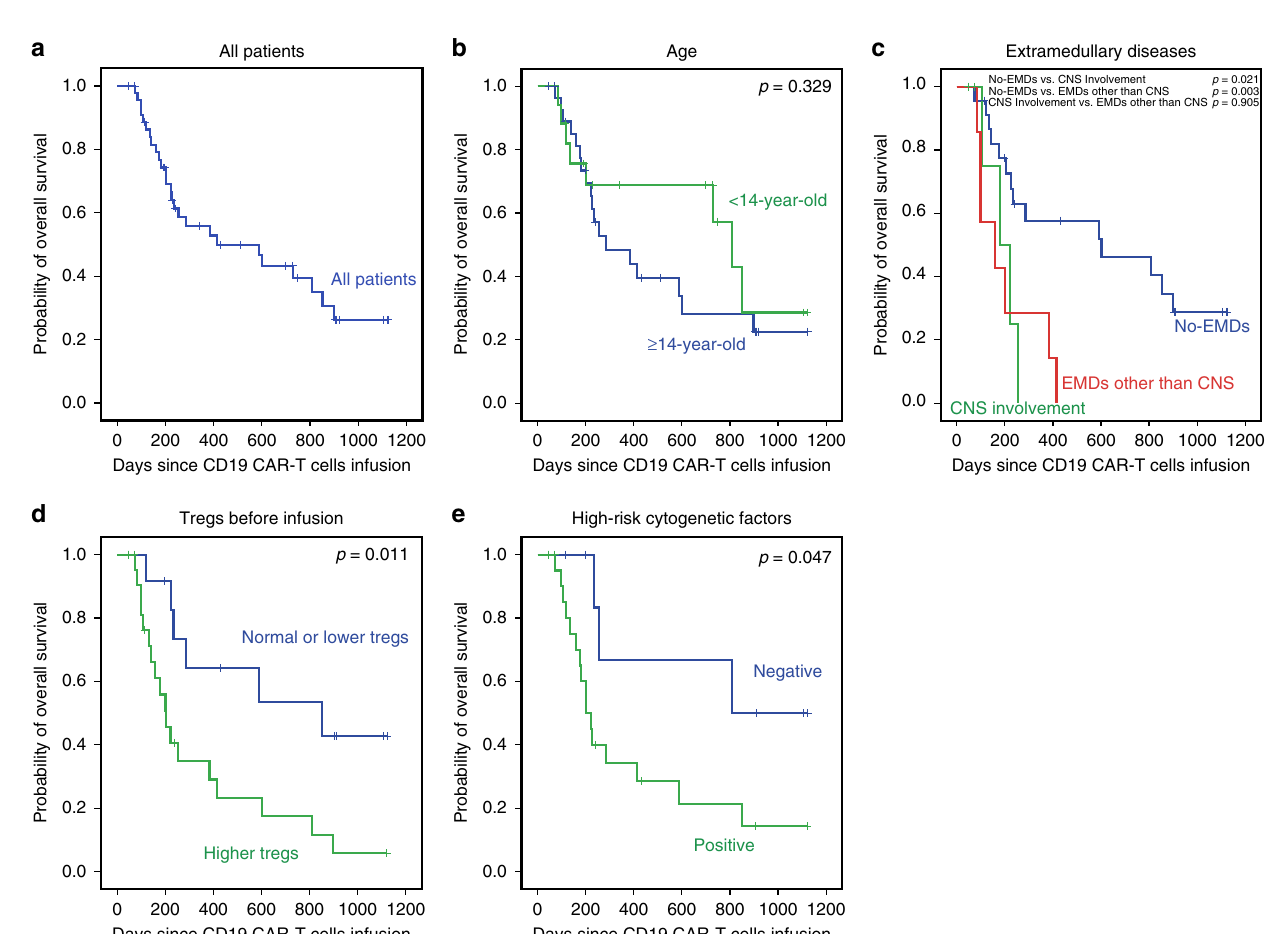
Fig. 2 Overall survival (OS) and subgroup analysis. a The OS in all patients who received Sino 19 infusion, the median OS was 415.0 days (95% CI: 15.5 – 814.5). The rate of OS at 1 year was 53.0% (95% CI: 37.2 – 68.8). b The OS between pediatric and adult cohort showed no signi fi cant difference ( p = 0.329). c The OS in patients with EMDs (CNS involvement only or EMDs other than CNS) was lower than that in patients without EMDs ( p = 0.021 and 0.003), respectively, but no signi fi cant difference was observed between the two EMDs subgroups ( p = 0.905). d The OS in patients with or without higher Tregs, 1-year OS rate was 29.3% vs. 64.2% ( p = 0.011). e The OS in patients with or without high-risk cytogenetic factors, 1-year OS rate was 34.3% vs. 66.7% ( p = 0.047). Patients who were bridged to allo-HSCT were excluded when we analyzed the in fl uence of patient characteristics on OS ( c – e ). b – e were performed by the Kaplan – Meier approach and used a two-sided log-rank test. Source data is provided as a Source Data fi le or available at